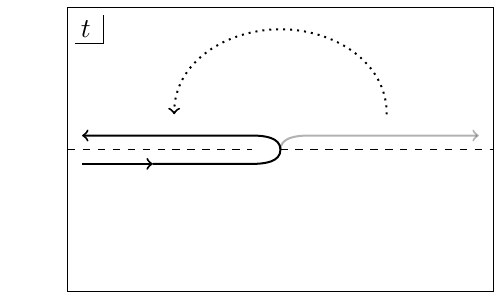
(a) When ∆ u > 0 , we can wrap the contour (b) When ∆ u < 0 , we can wrap the contour around the positive t -axis. around the negative t -axis. Figure 4. Depending on whether the integrand decays exponentially in the upper or lower half- plane, we can deform the contour in different ways. In both cases, the old contour is shown in gray and the new contour in black. The direction of deforming the contour is indicated with a dotted